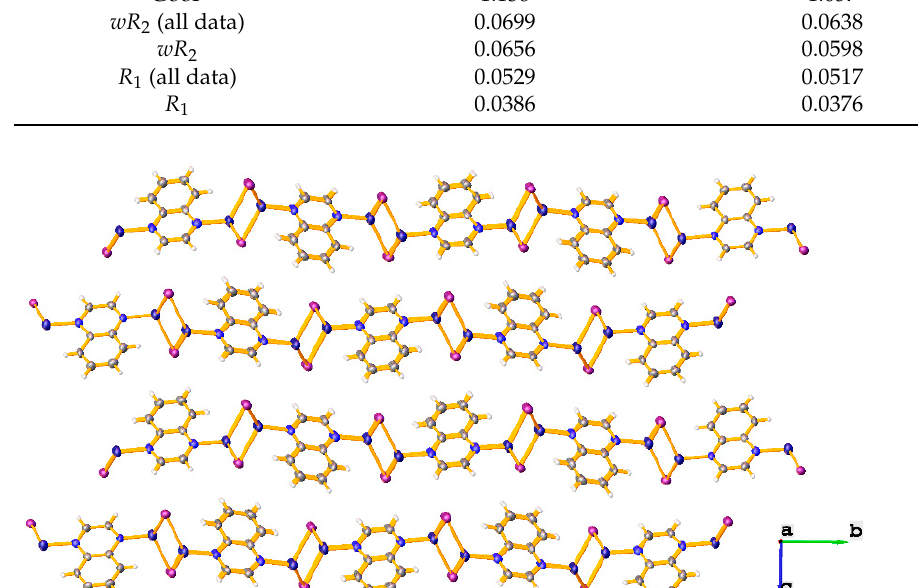
Figure 1. Thermal ellipsoids plot (50%) and labeling scheme for compound [(CuI) 2 (Quin)] at ambient conditions.